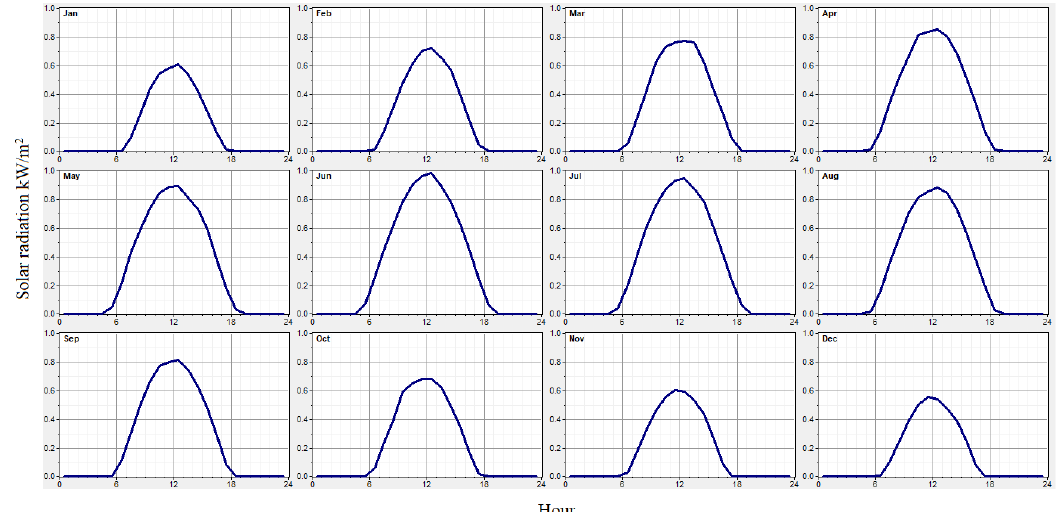
Figure 5. Variation of solar radiation intensity during the year.